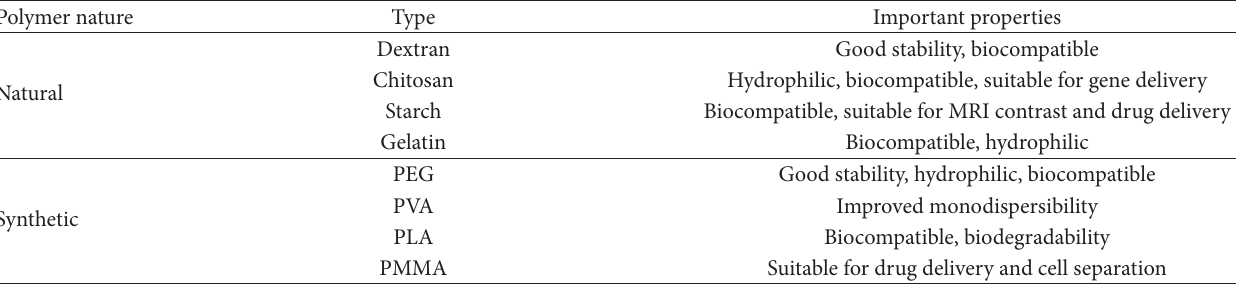
Table 5: Some of the functional polymers and their important properties